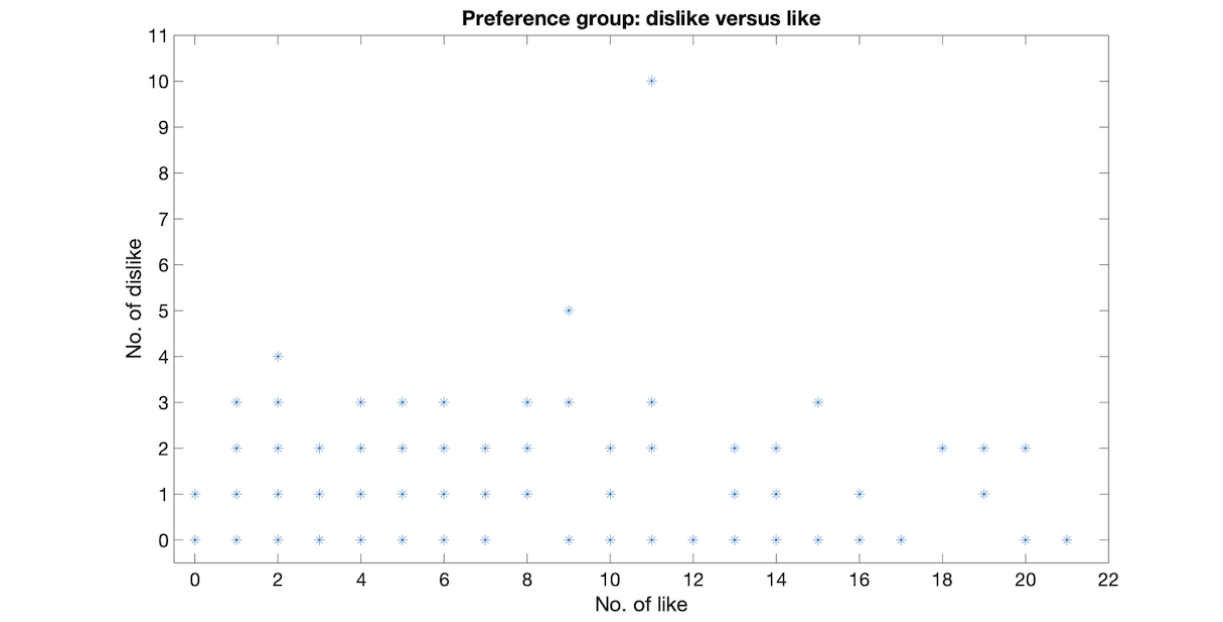
Figure 5. Like versus Dislike among the SMS message response ratings for participants in the feasibility